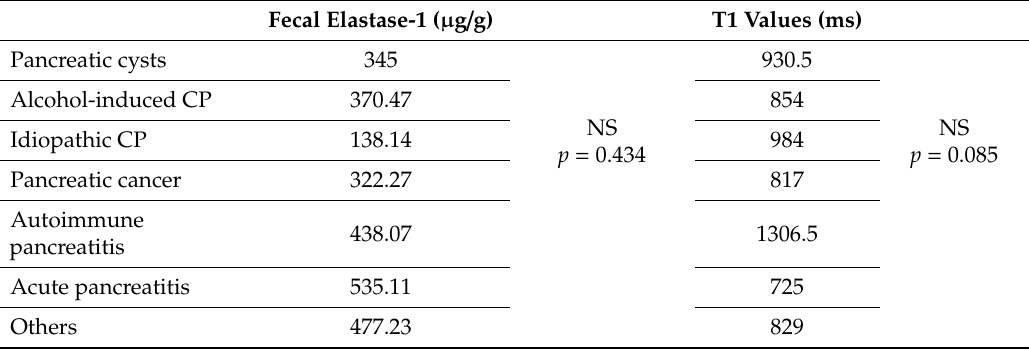
Table 3. Pancreatic exocrine function and pancreatic T1 values in each